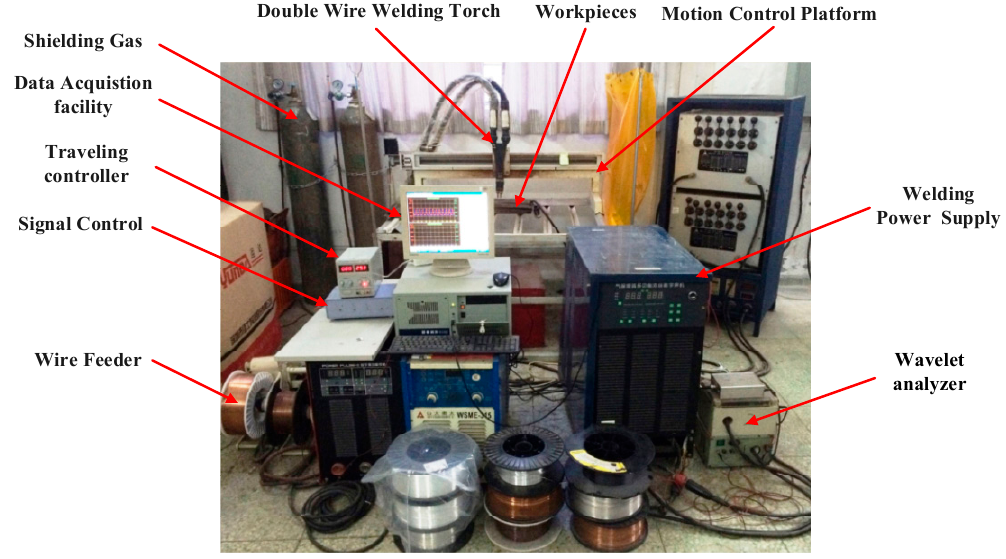
Figure 4. Integrated experiment platform used in this work.